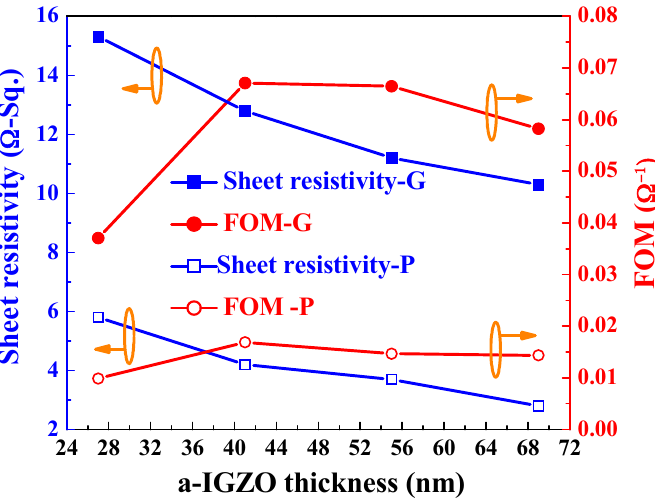
Figure 10. FOM values of the α -IGZO/Ag/ α -IGZO triple-layer structure as a function of thickness of α -IGZO film.